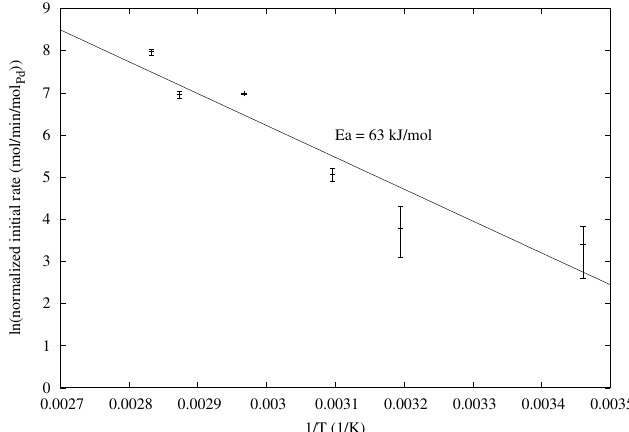
Figure 1. Arrhenius plot of Suzuki coupling of 4-iodoacetophenone and phenylboronic acid. The initial rates are normalized by the mass of Pd. Conditions: 4-iodoacetophenone (0.05 mol/L, 1 eq.), phenylboronic acid (0.06 mol/L, 1.2 eq.), MeONa (0.075 mol/L, 1.5 eq.), Pd (5 · 10 − 6 mol/L), and ethanol (20 mL).